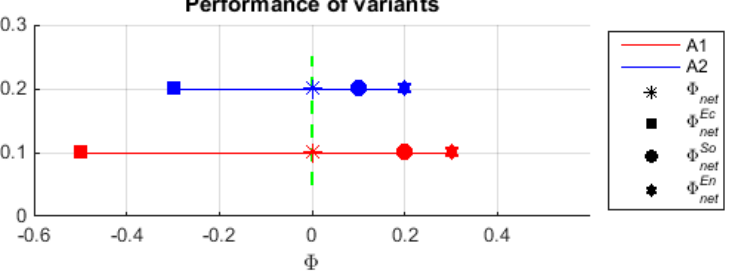
Figure 1. Evaluation of two examples of variants in terms of economic, social and environmental criteria, and their global assessment.